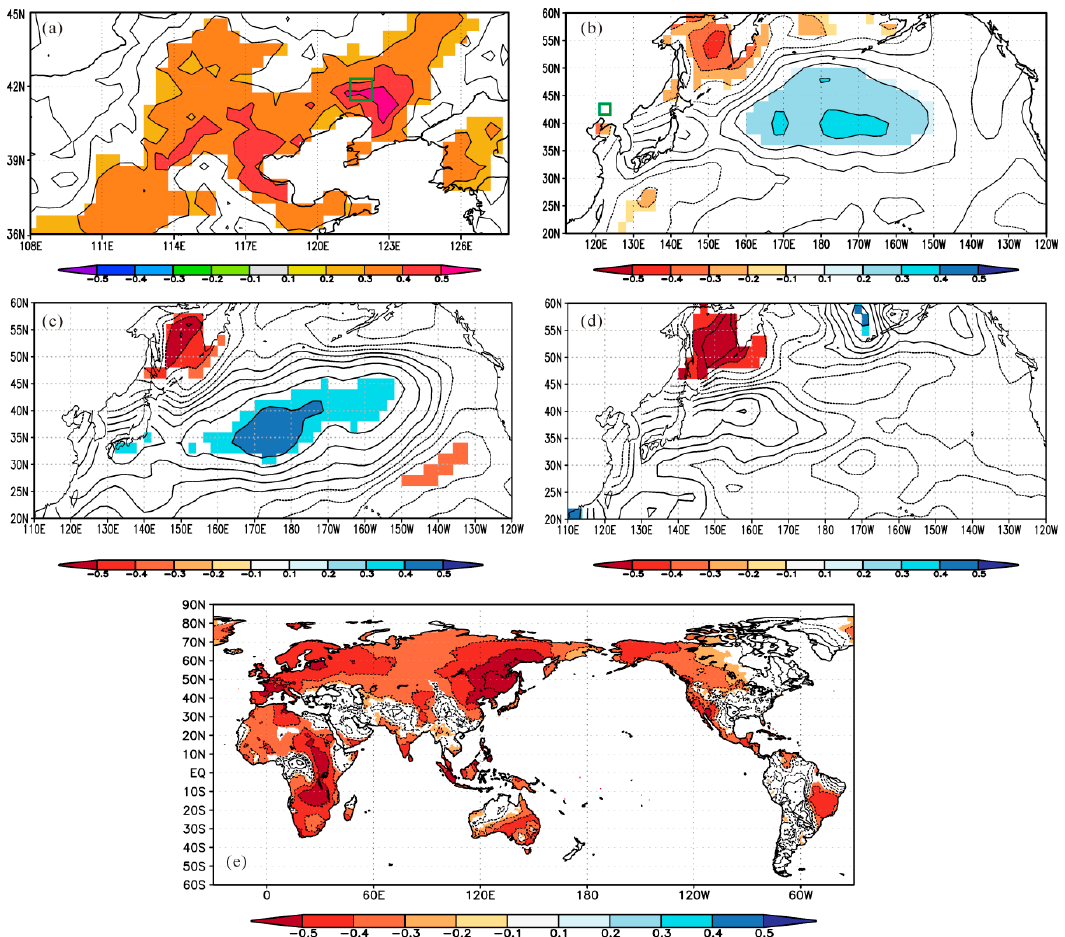
Figure 5. Spatial correlations of the reconstructed January–September mean self-calibrating